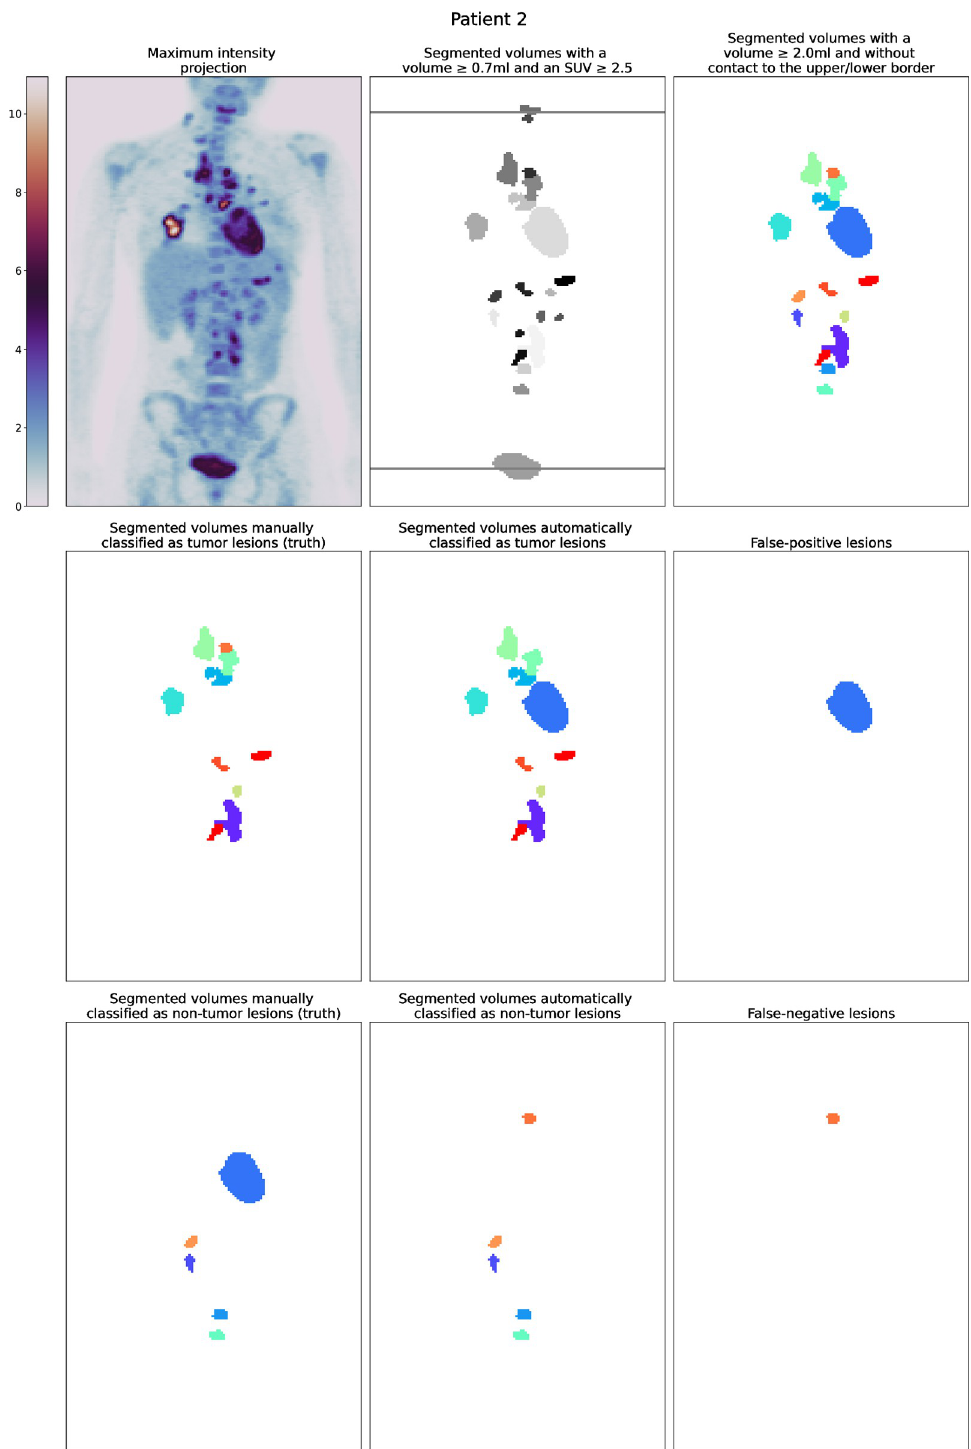
Fig 3. Patient from the EuroNet-PHL-C1 study with a suboptimal automatic classification and incorrect cropping at the upper border.